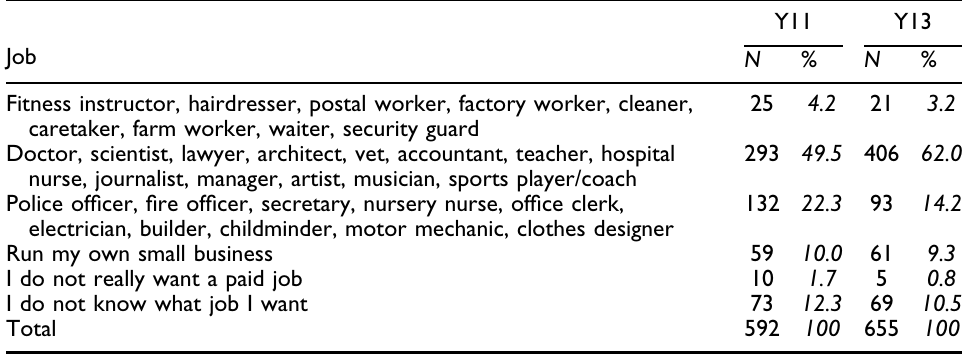
Table 4. Responses to ‘ What type of job would you like to do in the future ’.